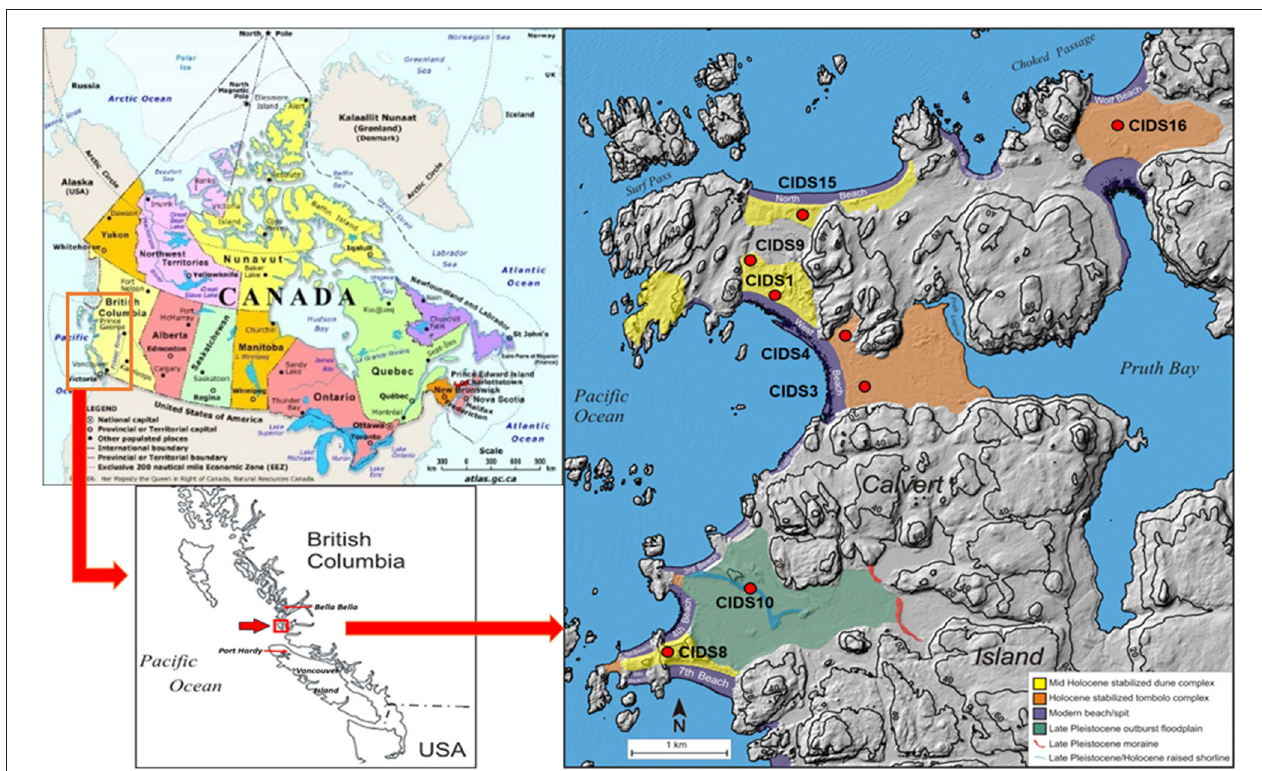
FIGURE 1 | Map of study site on Calvert Island, BC, Canada. The map of Canada is from The Atlas of Canada, available at https://www.nrcan.gc.ca/maps-tools- and-publications/maps/atlas-canada/10784. The maps showing more details of the sampling locations are from Nelson (2018), and were adapted from Neudorf et al. (2015) . Sampling sites are denoted with red